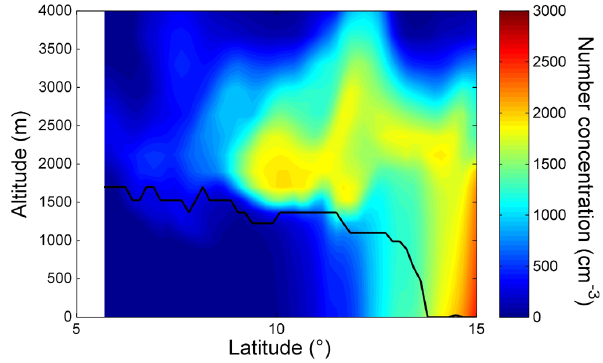
Fig. 10. Cross-section of dust number concentration for the simu- lation including sedimentation (NORAD-SED) at 12:00UTC on 13 June. The black line illustrates the top of the monsoon